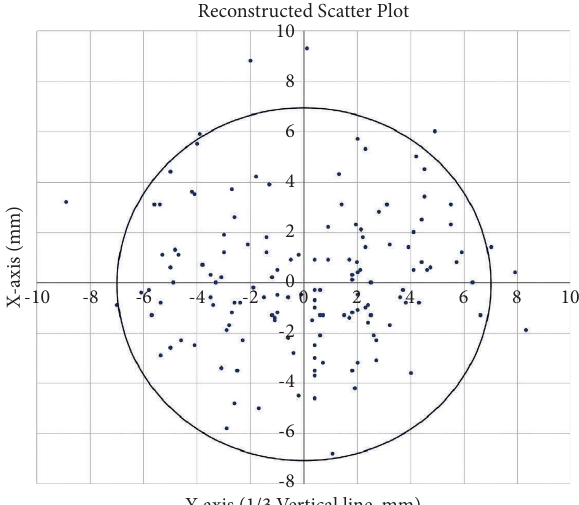
Figure 3: Keypoint coordinates show that 89.77% (139/149) of the keypoints were located within a 7mm radius circle, with the center at ( − 0.41, − 3.01) in the coordinate